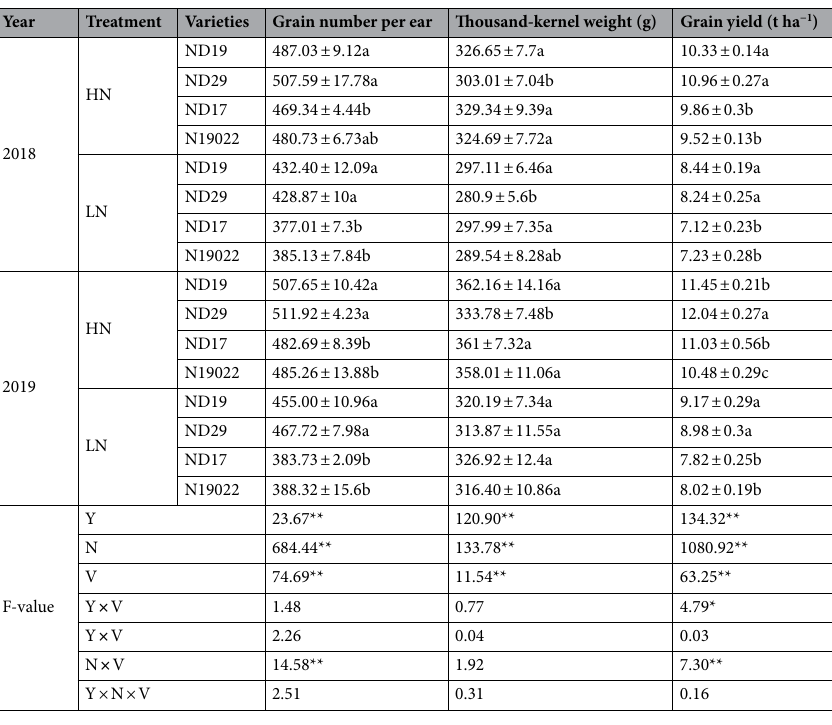
Table 3. Grain yield and yield components of the four varieties under different nitrogen rate. HN high nitrogen conditions, LN low nitrogen conditions. * and **F values significance at 0.05 and 0.01 probability levels, respectively. Different letters represent significant differences among varieties.